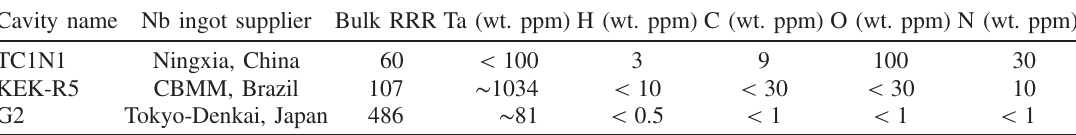
TABLE I. Purity and manufacturer of the ingots used for the fabrication of the three single-cell cavities used in this